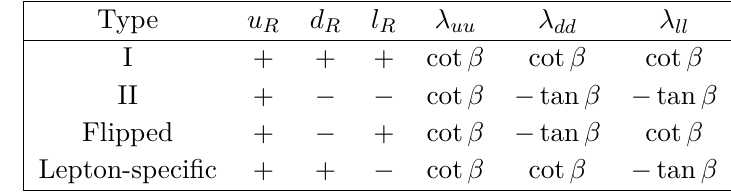
Table 1. Assignment of the Z 2 charges to the right-handed fermions for the different types of 2HDMs. The resulting coefficients of the charged Higgs-fermion interaction are also